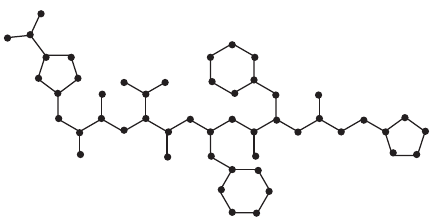
Figure 4: Molecular graph of Ritonavir.